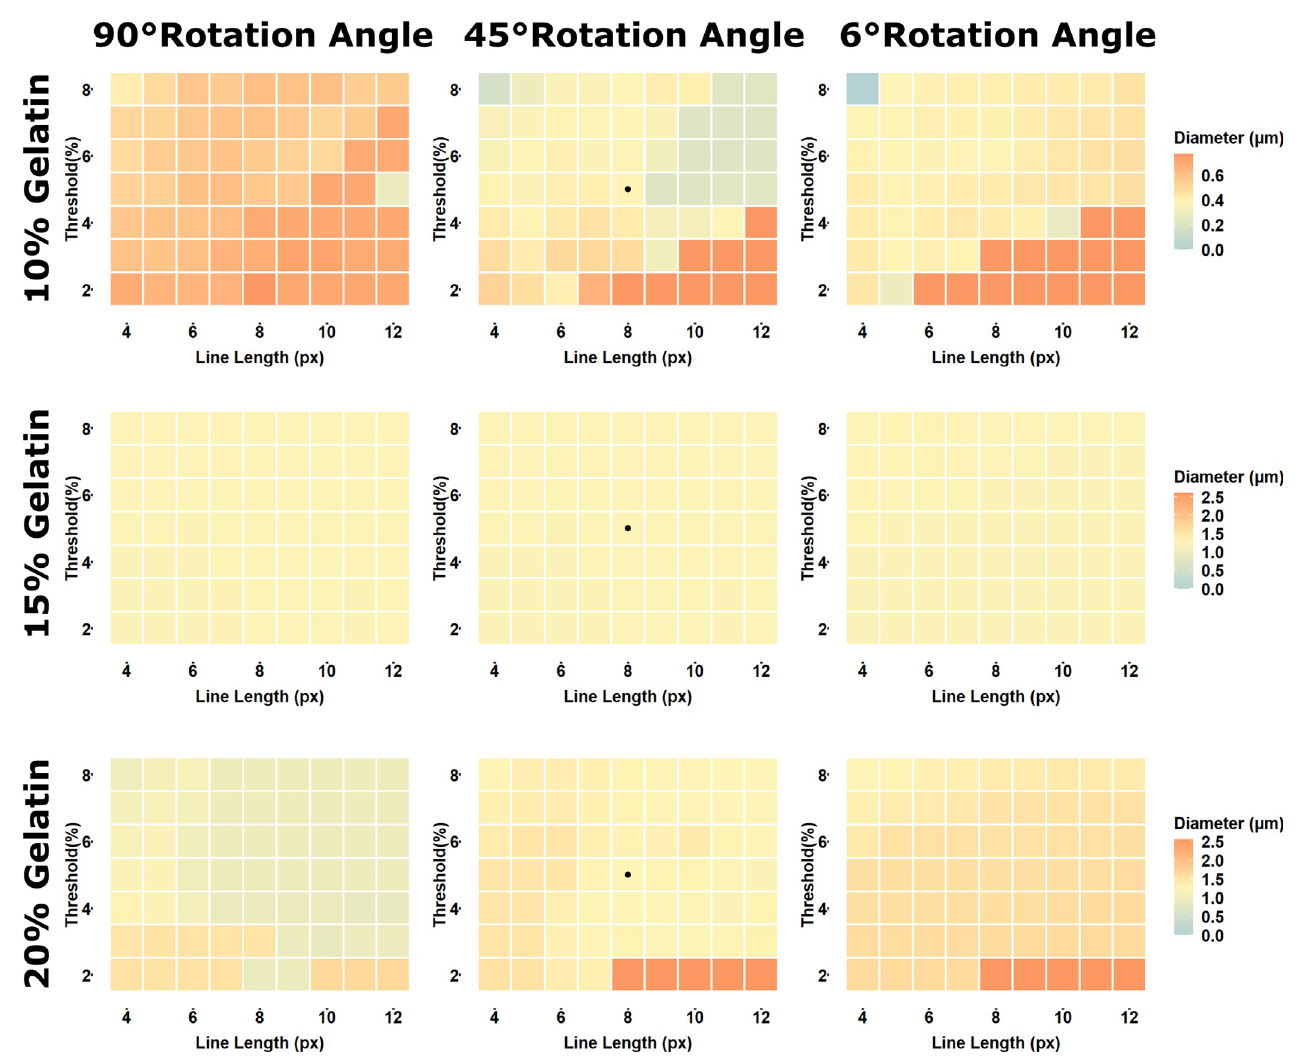
Fig 3. GIFT parameter sensitivity. SEM images of 10, 15 or 20% gelatin electrospun fibers were analyzed using the GIFT macro with 90, 45 or 6˚ angles of rotation and at all combinations of 4–12 pixel line length and 2–8% threshold parameters. The resulting fiber diameter measurements were graphed as heatmaps to visualize sensitivity of GIFT to changes in parameters. All graphs for each image (rows) have the same scale, with the fiber diameter measured with default parameters set as the midpoint of the scale bar (yellow color). Average diameters higher than the default are represented by increasingly red hues and diameter results lower than the default are increasingly blue in color. The black dots indicate the results under default parameters for reference.